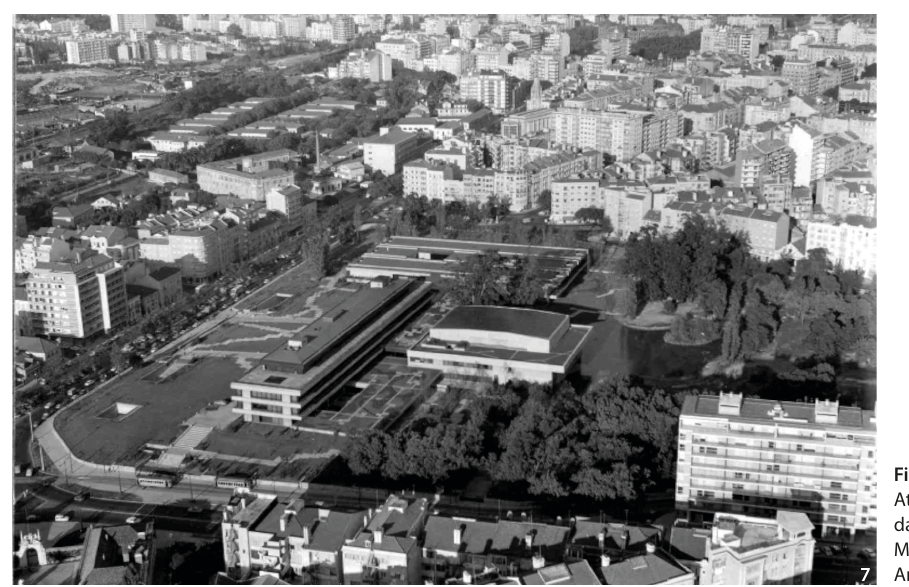
Figure 7 Alberto Pessoa, Pedro Cid, Rui Athouguia, Calouste Gulbenkian Foun- dation, Lisbon, Portugal, 1969 (Source: Mário de Oliveira, Calouste Gulbenkian